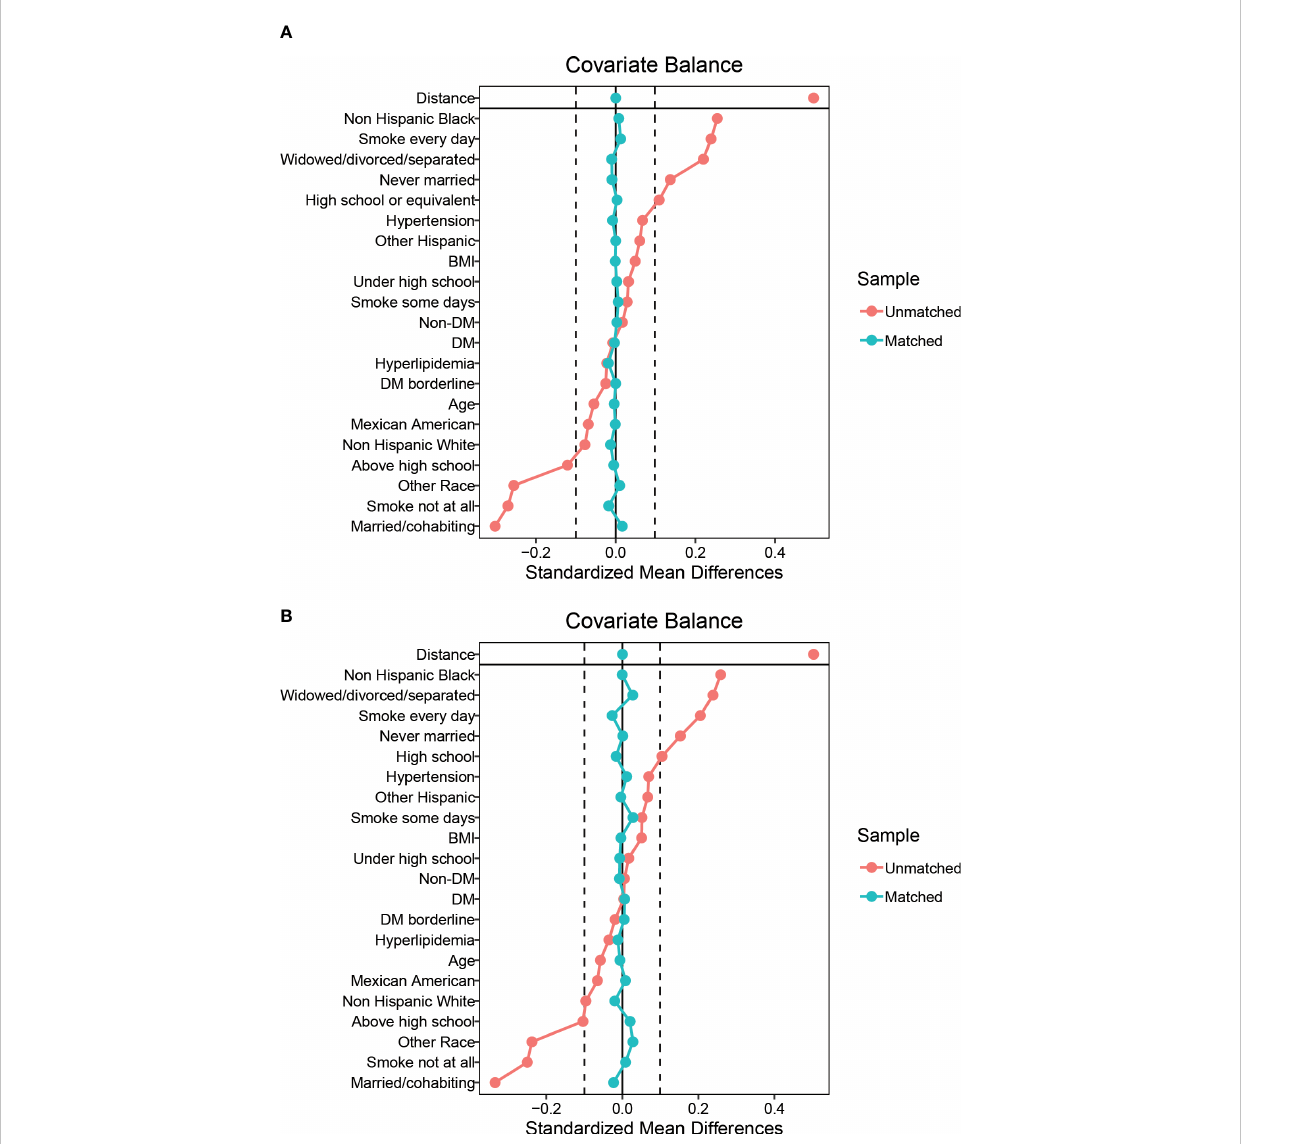
FIGURE 2 Balance diagnostics plot for HPV infection data, before and after matching. (A) Standardized differences shown for each baseline confounder variable of HPV infection cohort before weighting. (B) Standardized differences shown for each confounder variable of HPV infection cohort after weighting. Vertical dotted lines indicate the desired balance level. The X-axis represents the standardized differences value, and the Y-axis represents baseline variables. HPV, Human papillomavirus; BMI, body mass index; DM, diabetes mellitus.